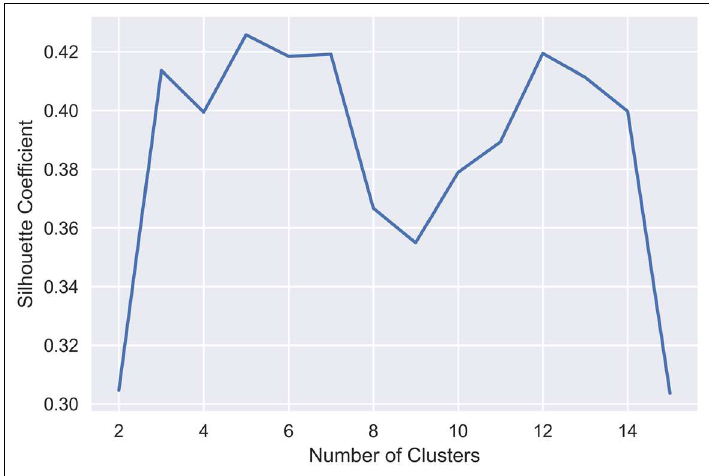
Figure 8. The silhouette coefficient under the different numbers of clusters.